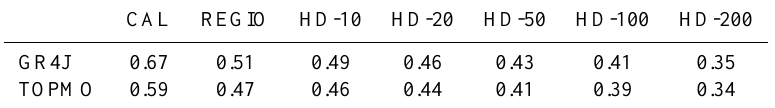
Table 2. Mean C2M values over the 907 catchments of the data set, with calibration (CAL), regionalisation (REGIO), and with the hydro- metrical desert (HD) defined by increasing distance (10, 20, 50, 100 and 200km).